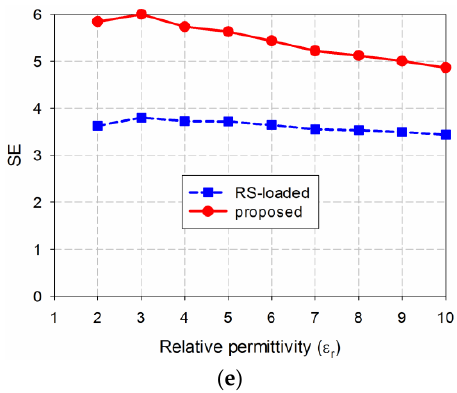
Figure 5. Sensitivity comparison of the three MPSAs: ( a ) Δ f r ; ( b ) PRFS; ( c ) PRFSE; ( d ) S; and ( e ) SE.